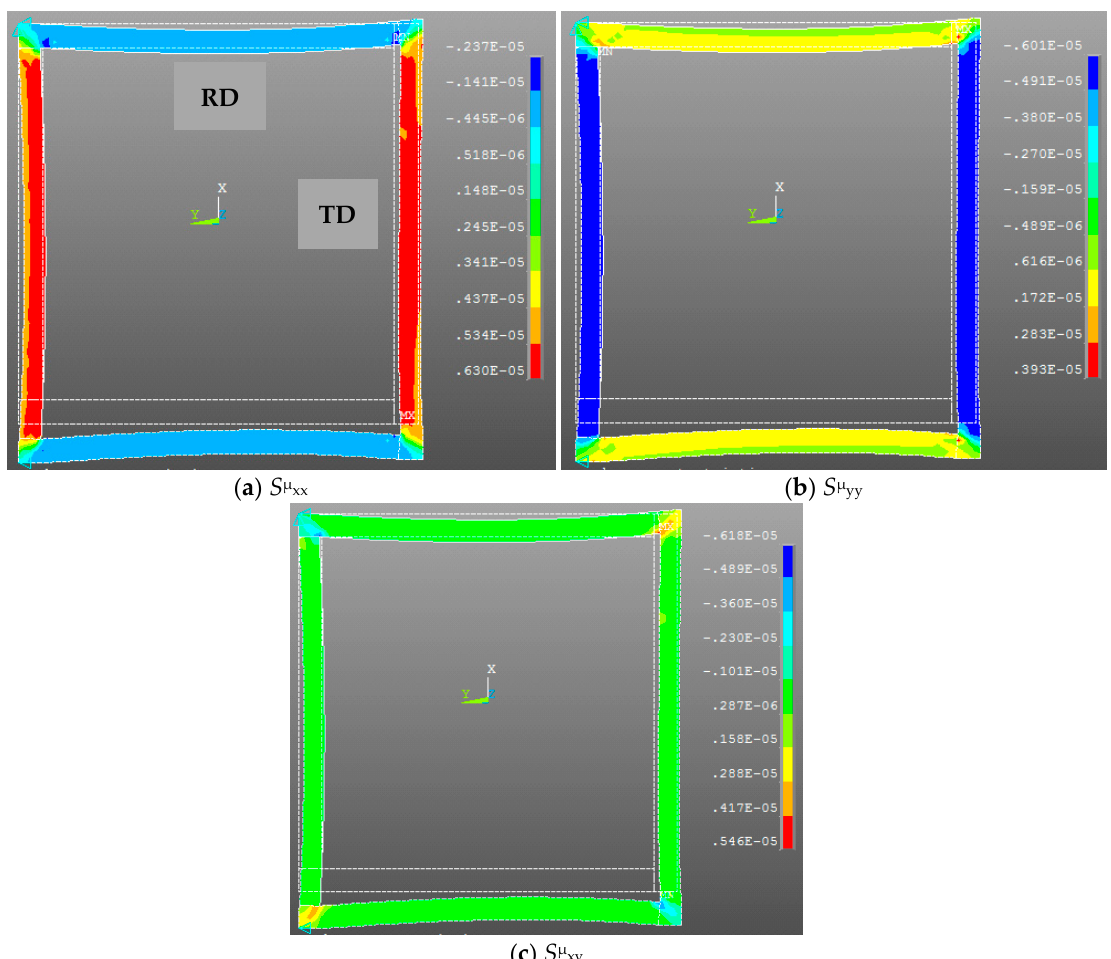
Figure 8. Simulated magnetostriction of the test bench (at the same point corresponding to the maximum strain along the TD column): Normal magnetostrictive strain along the X ‐ axis ( a ); Normal magnetostrictive strain along the Y ‐ axis ( b ); Shear magnetostrictive strain XY ( c ).